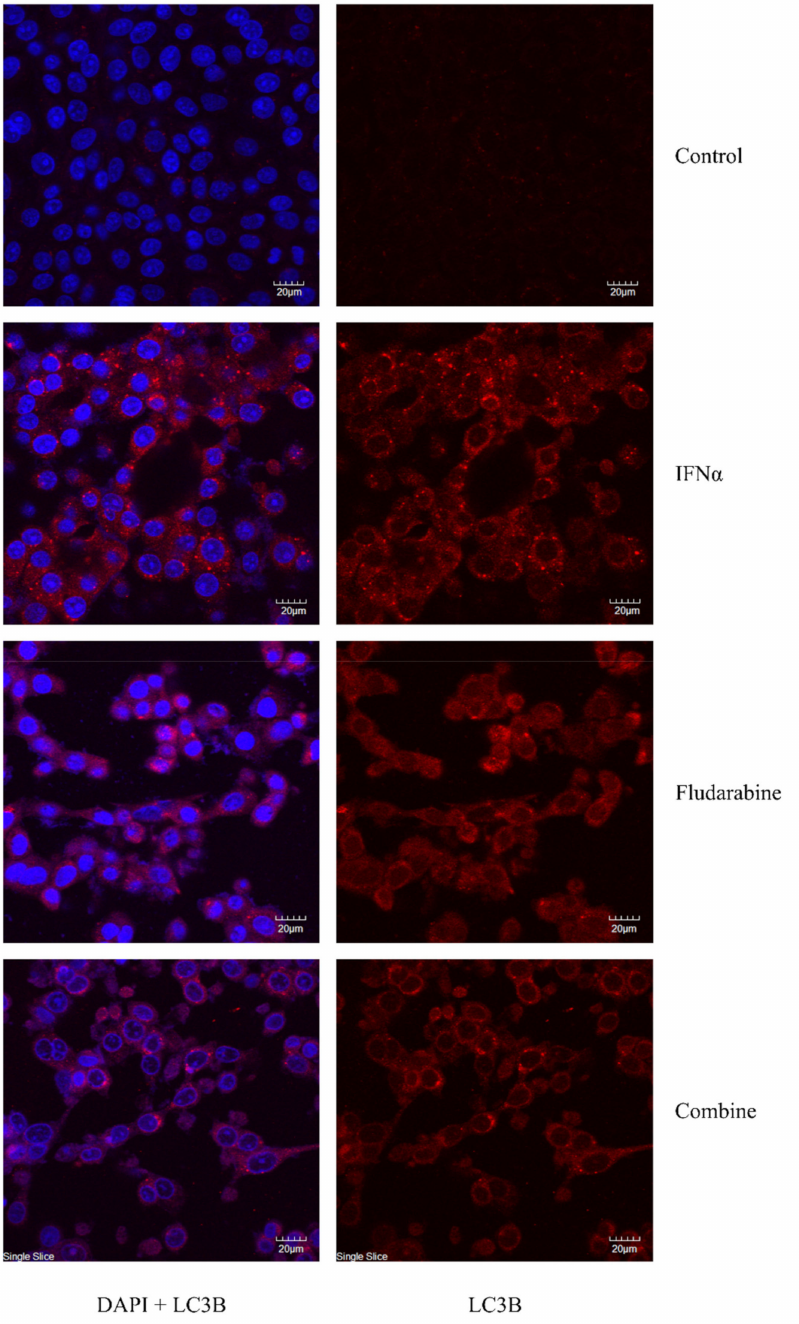
Figure 6. Confocal immunofluorescent micrographs of LLC-MK2 cells after exposure to IFN- α (10 U/mL) for 60 min before treatment with Fdb (10 µ M) for an additional 24 h. The cells were briefly fixed in absolute methanol at − 20 ◦ C and permeabilized with 0.1% Triton X-100 before being immunohistochemically stained with autophagy-activated protein (LC3B-I/LC3B-II) antibody and secondary antibody-conjugated Alexa ® 555. The fluorescent illumination demonstrated the clustering of LC3B foci or autophagosome formation in the cytoplasm of the cells. LC3B Alexa ® -stained = red, DAPI nuclear-stained =